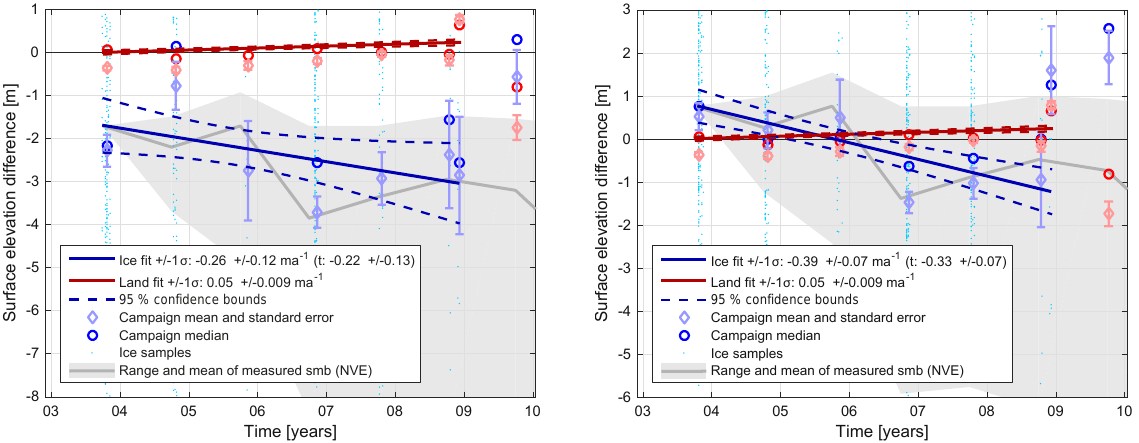
Figure 6. Surface elevation difference trends for land (red) and ice (blue) samples respectively, for autumn campaigns 2003–2008. Left: per-tile and -elevation corrections ( c tile , c H ) applied, 1233 samples. Right: per-tile, -elevation and -glacier correction ( c glac ) applied, 1105 samples. Trends are computed from individual dh samples using robust linear regression. Campaign median and mean ± standard error per campaign and class are shown to indicate the variability in dh per campaign. The grey spread corresponds to the measured range of cumulative surface mass balances of eight glaciers in the area, reconverted to ice volume changes using a density of 850kgm − 3 (Andreassen et al., 2016), and their area-weighted mean. The data provided by NVE are based on in situ and geodetic